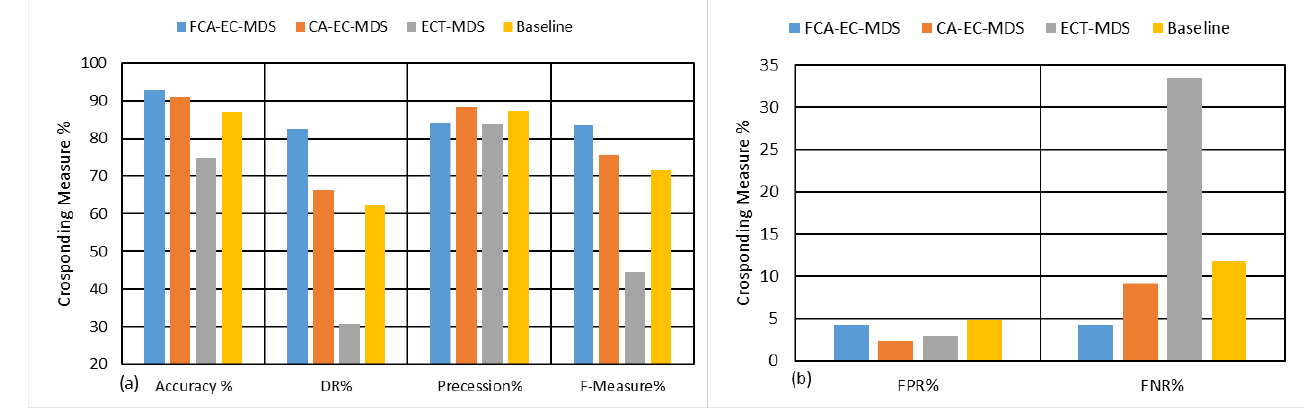
Figure 6. Performance comparison between the proposed FCA-MDS model and the related works in terms of ( a ) accuracy, DR, precession, and F-measure and ( b ) FPR and FNR. Table 3. Results of performance evaluation.